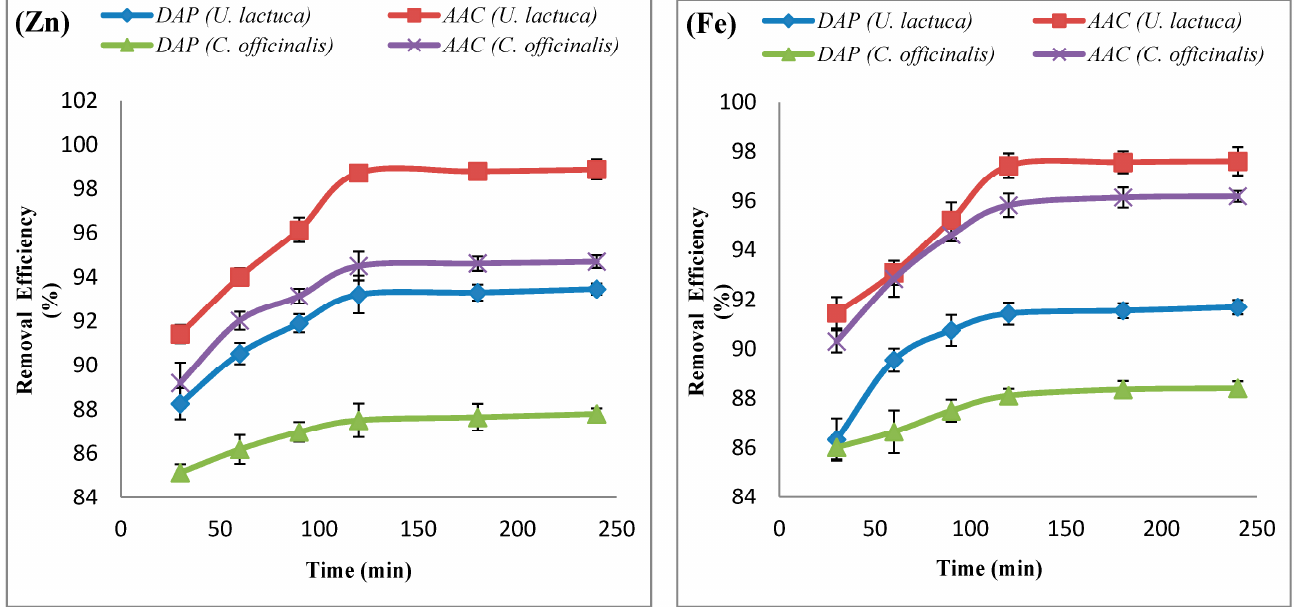
Figure 2. Effect of contact time (min.) on the percentage of removal for Zn +2 and Fe +3 (at pH 5.0 by using 50 mg.L − 1 metal-ion concentration and 1.0 g.L − 1 ) by using dried algal powder (DAP) and the activated carbon (AAC) of both U. lactuca and C. officinalis. Each data point represents the mean ± SD.